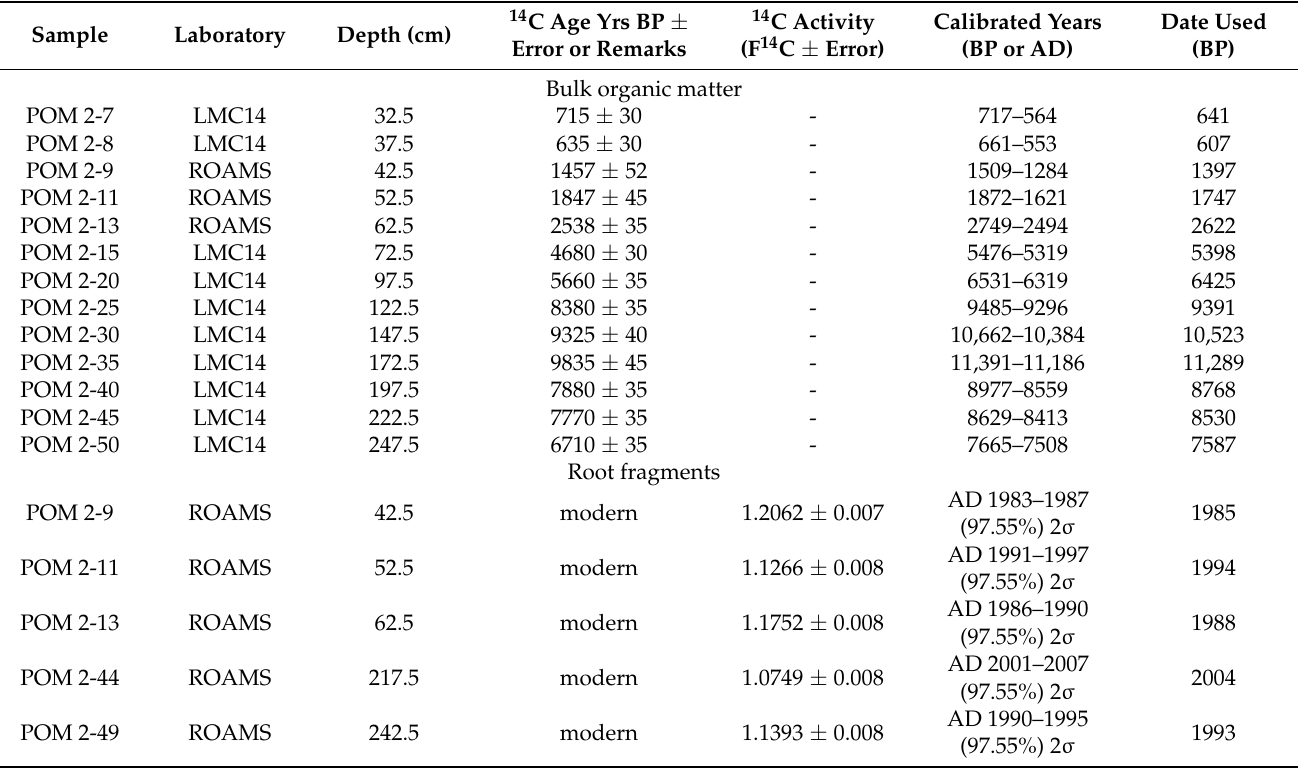
Table 2. Radiocarbon ages, the calibrated years BP/AD and the dates used for construction of the age-depth model.